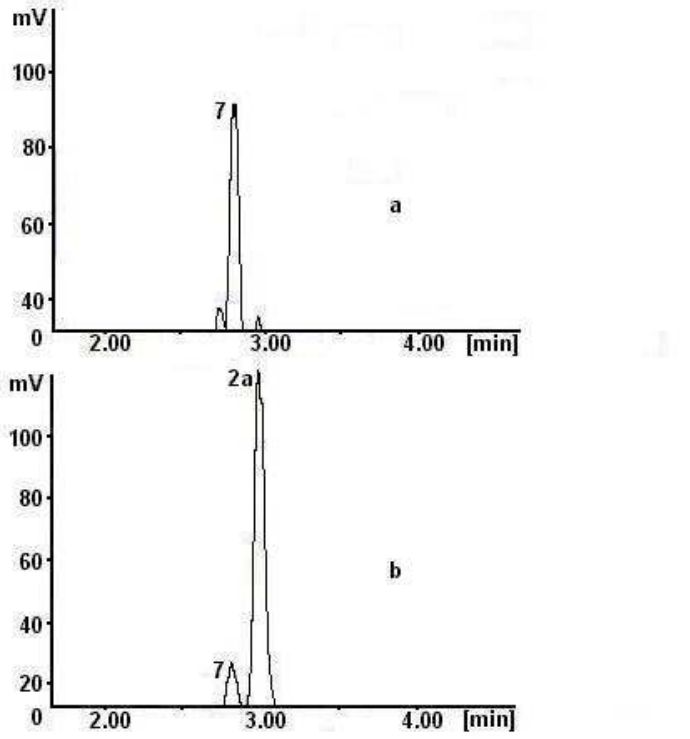
Fig. 3 HPLC monitoring (212 nm) of the 1,3-bis(dimethylaminomethyl)benzene ( 2a ) synthesis: a) chromatogram of m − xylylendiamine ( 7 ); b) chromatogram of 1,3-bis(dimethylaminomethyl)- benzene ( 2a